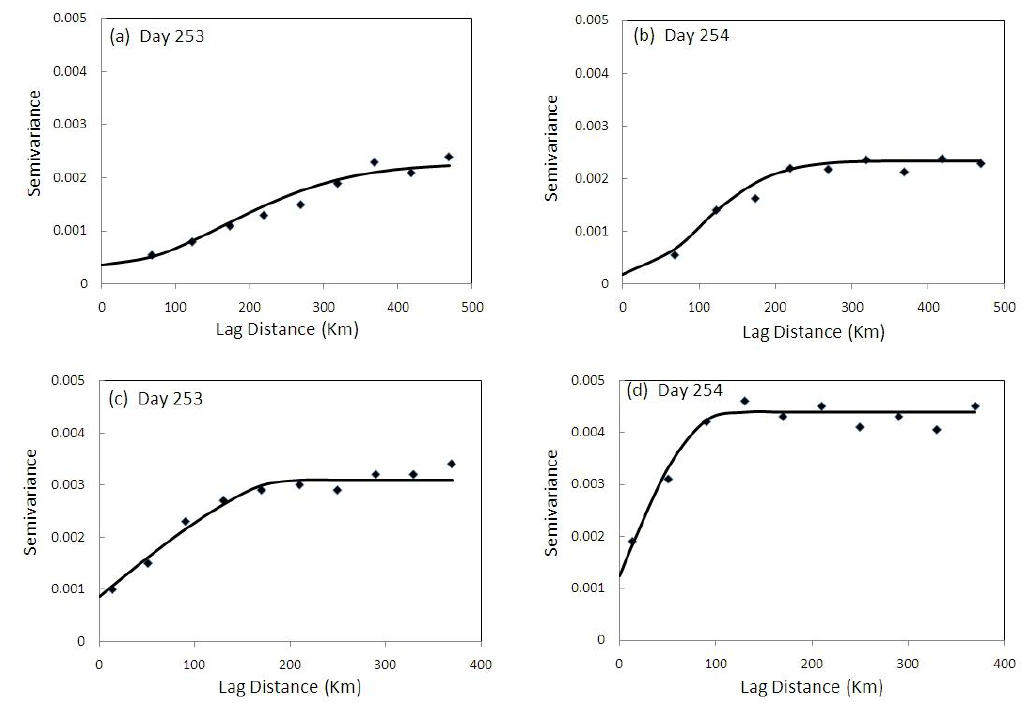
Figure 6. Soil moisture variograms of AGRMET (a-b) and Oklahoma Mesonet (c-d), where symbols are the experimental semi-variances and the solid lines show the fitted model. Variograms (a) and (c) are before precipitation event (253 day), and (b) and (d) after a precipitation event (254 day). Gaussian and Spherical models best fit the AGRMET and Oklahoma Mesonet soil moisture data,